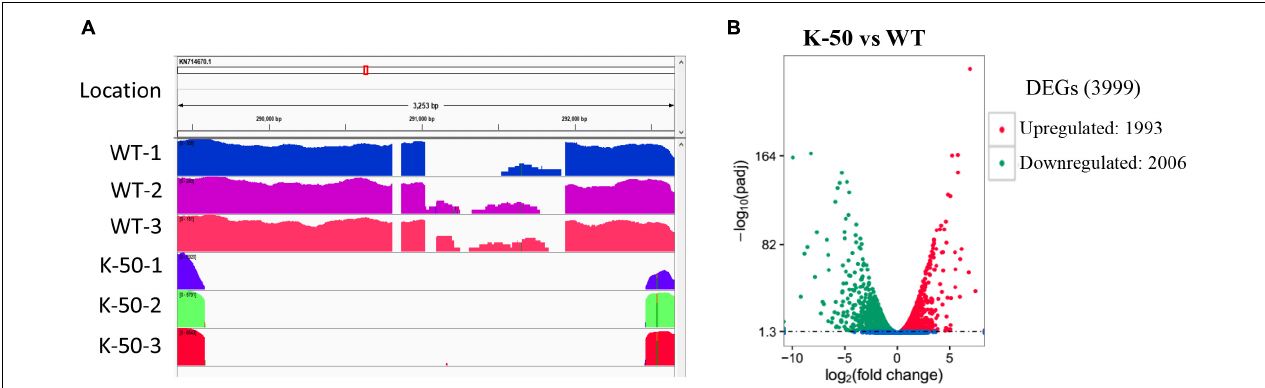
FIGURE 5 | Gene characterization and analysis of differentially expressed genes (DEGs). (A) The reads from the wild type (Vp297) and K-50 mutant mapped to the fragment including the knockout site. (B) Volcano plot of DEGs between K-50 and WT. The x -axis represents the log 2 -fold change. The y -axis represents –log10 adjustments (padj). The red spots indicate upregulated DEGs, and the green spots indicate downregulated DEGs.